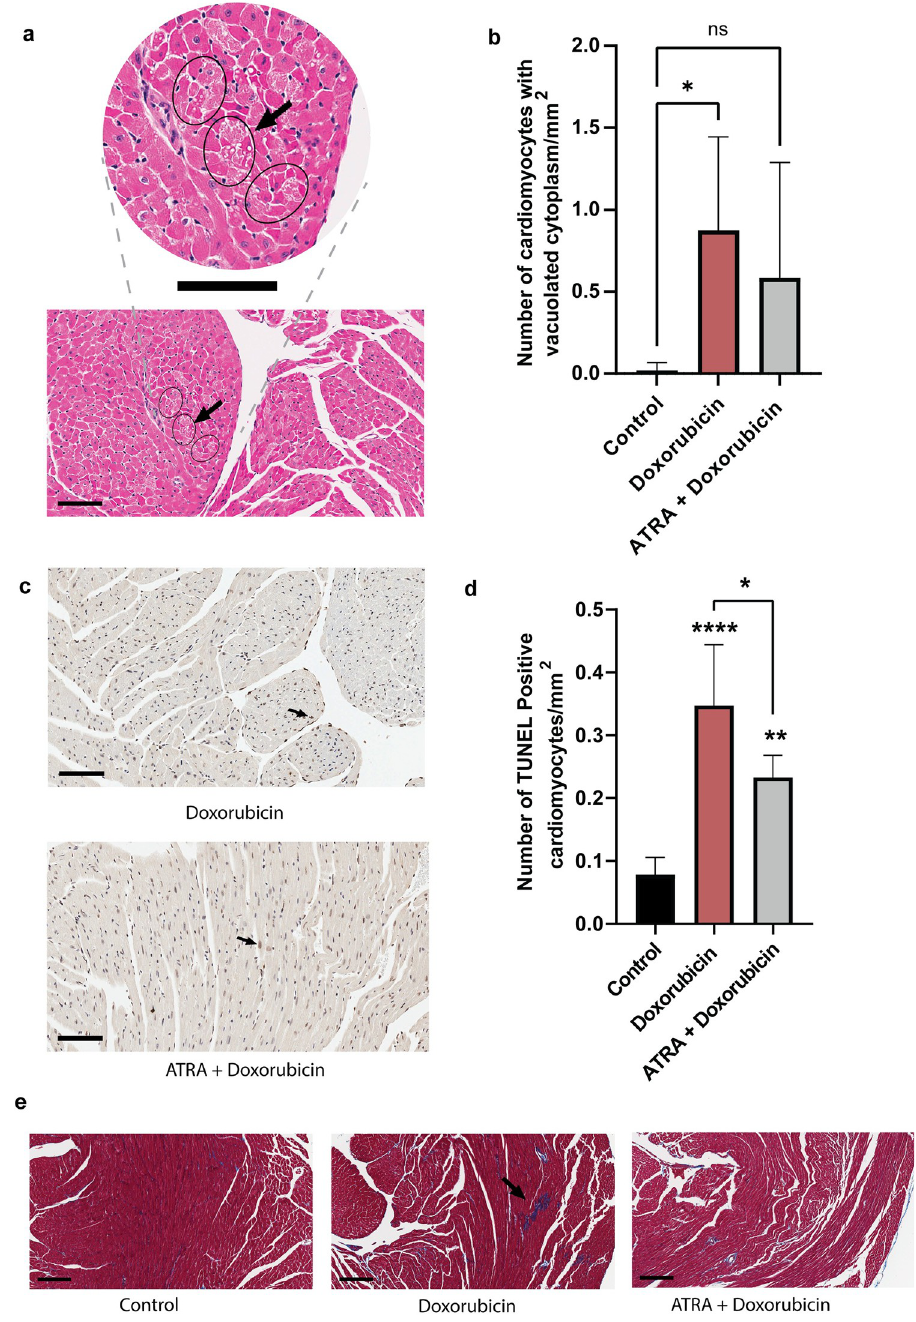
Fig 5. ATRA is cardioprotective in doxorubicin-treated mice as demonstrated by histological analysis. (a) Representative image of cytoplasmic vacuolization in H&E-stained heart tissue section of doxorubicin-only treated mice. The arrow indicates cytoplasmic vacuolization. A zoomed-in view of the cytoplasmic vacuolization is shown on top. Scale bars, 100 μ m. (b) Number of cardiomyocytes with vacuolated cytoplasm in the H&E-stained tissue sections of control (saline-treated), doxorubicin-only-treated, and ATRA + doxorubicin-treated mice (N = 5 mice per group). Data are presented as mean ± standard deviation. Statistical analysis was performed using a one-way ANOVA and Dunnett’s multiple comparisons correction (control vs. doxorubicin: � P = 0.0435, control vs. ATRA + doxorubicin: P = ns). (c) Representative image of TUNEL-stained heart tissue sections of doxorubicin-only treated, and ATRA + doxorubicin-treated mice. The arrow indicates TUNEL-positive cardiomyocyte. Scale bars, 100 μ m. (d) TUNEL staining to detect DNA fragmentation during apoptosis. The graph depicts the number of